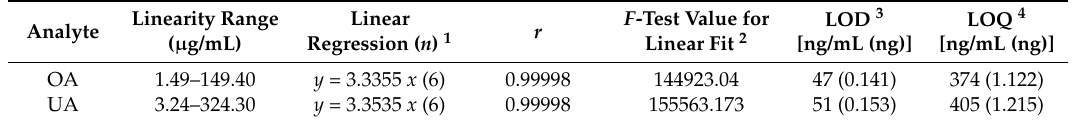
Table 4. Linear regression and sensitivity data.